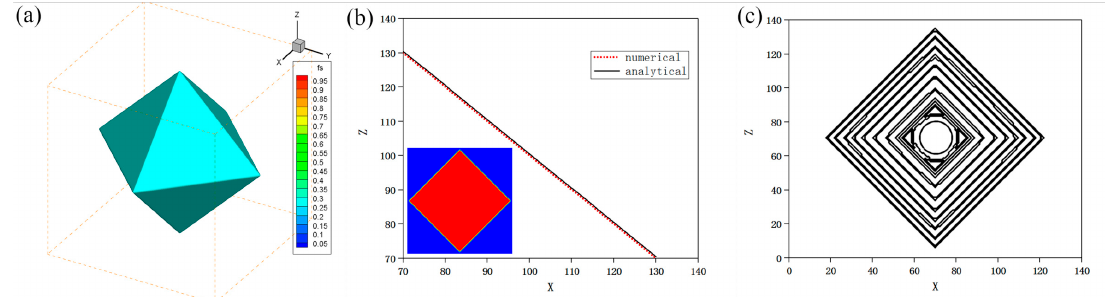
Figure 3. ( a ) Three-dimensional solid state rate results ( b ) x-z cross section equilibrium solid state rate and comparison of simulation and analytical solution ( c ) cross section of solid-liquid interface evolution.